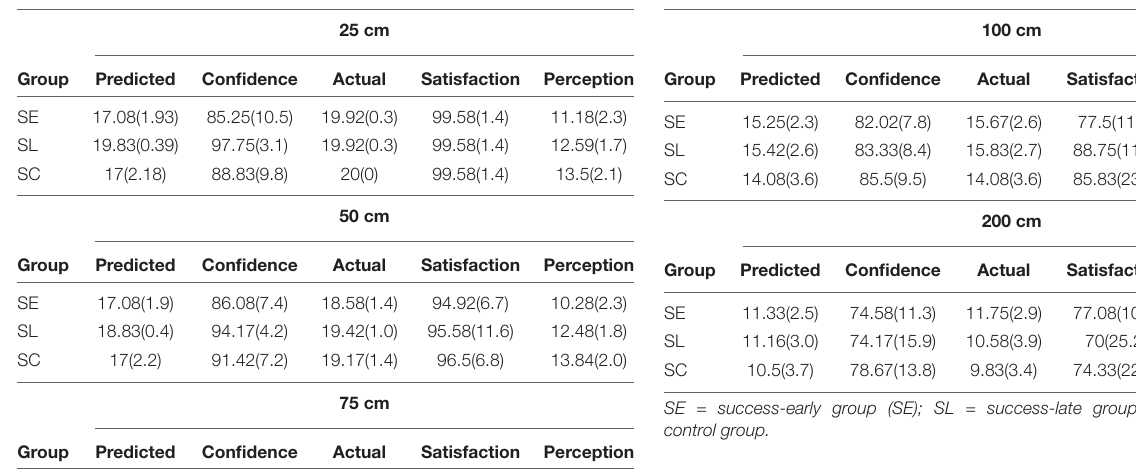
TABLE 2 | Retention (RT) means (and standard deviations) for participants’ score predictions, confidence levels, actual putting scores, satisfaction levels and perception values by group at both